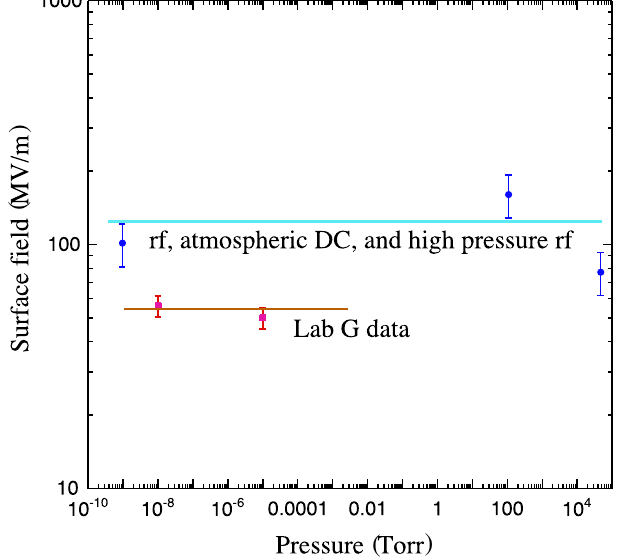
FIG. 18. (Color) The figure shows (a) the cavity from Ref. [8] with the location of the breakdown events, (b) the window covered with spray from breakdown events, and (c) the approxi- mate angular distribution of the